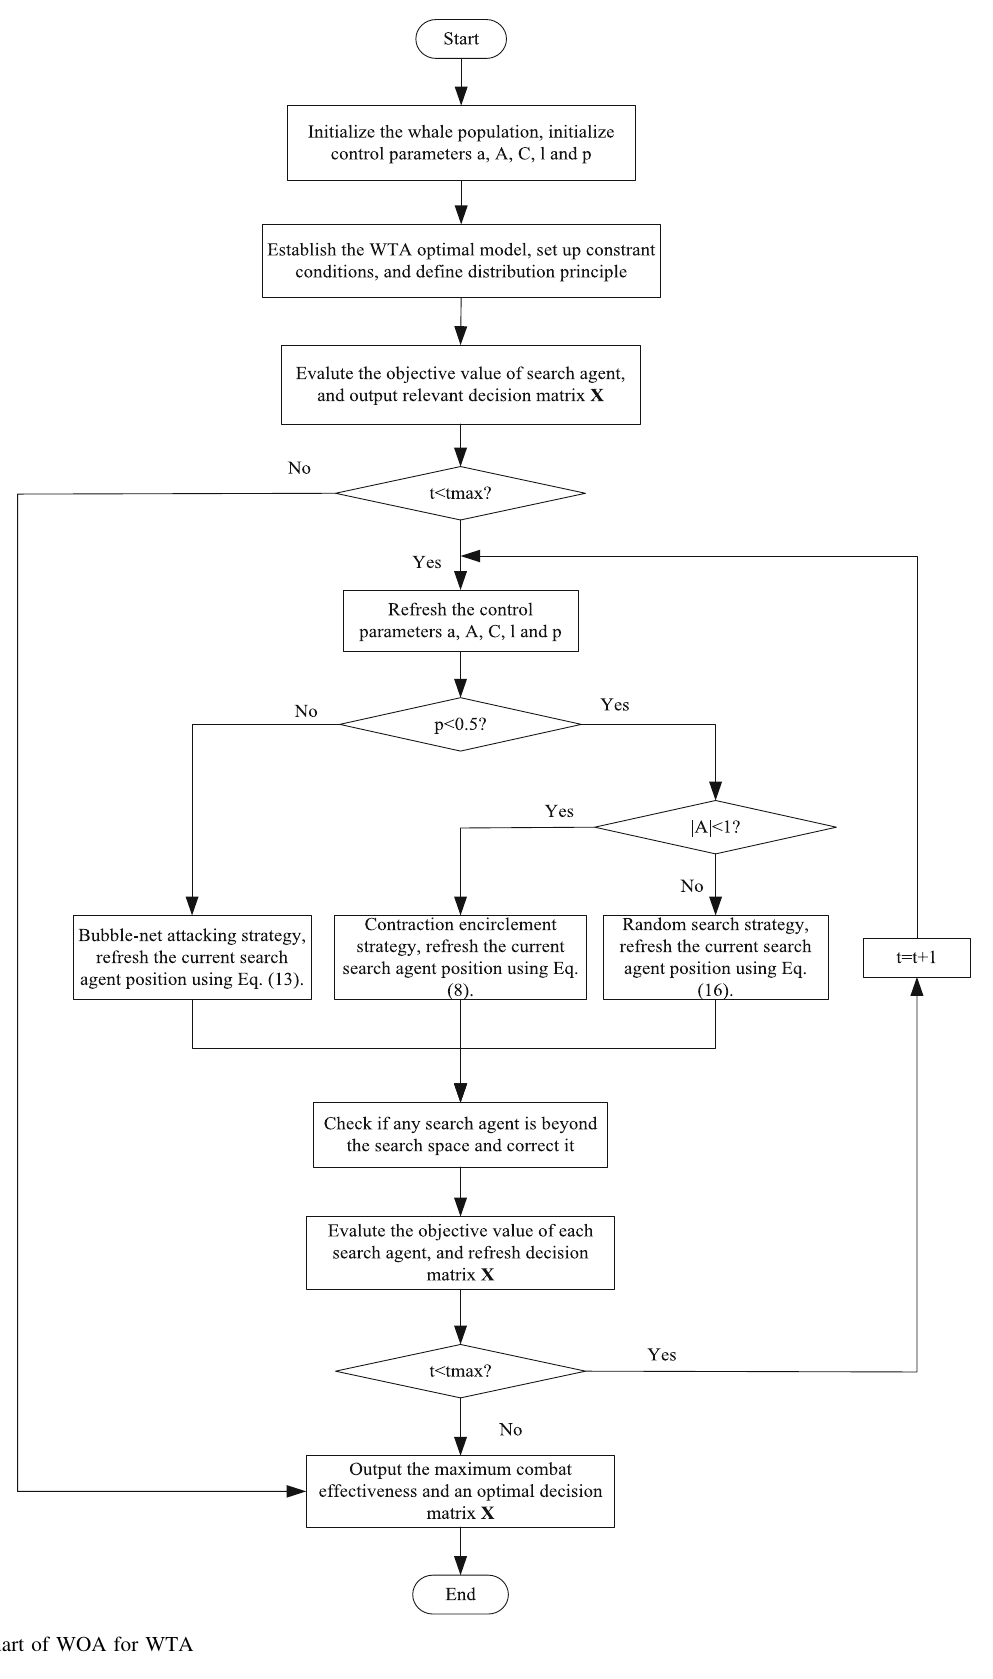
Fig. 2 Flowchart of WOA for